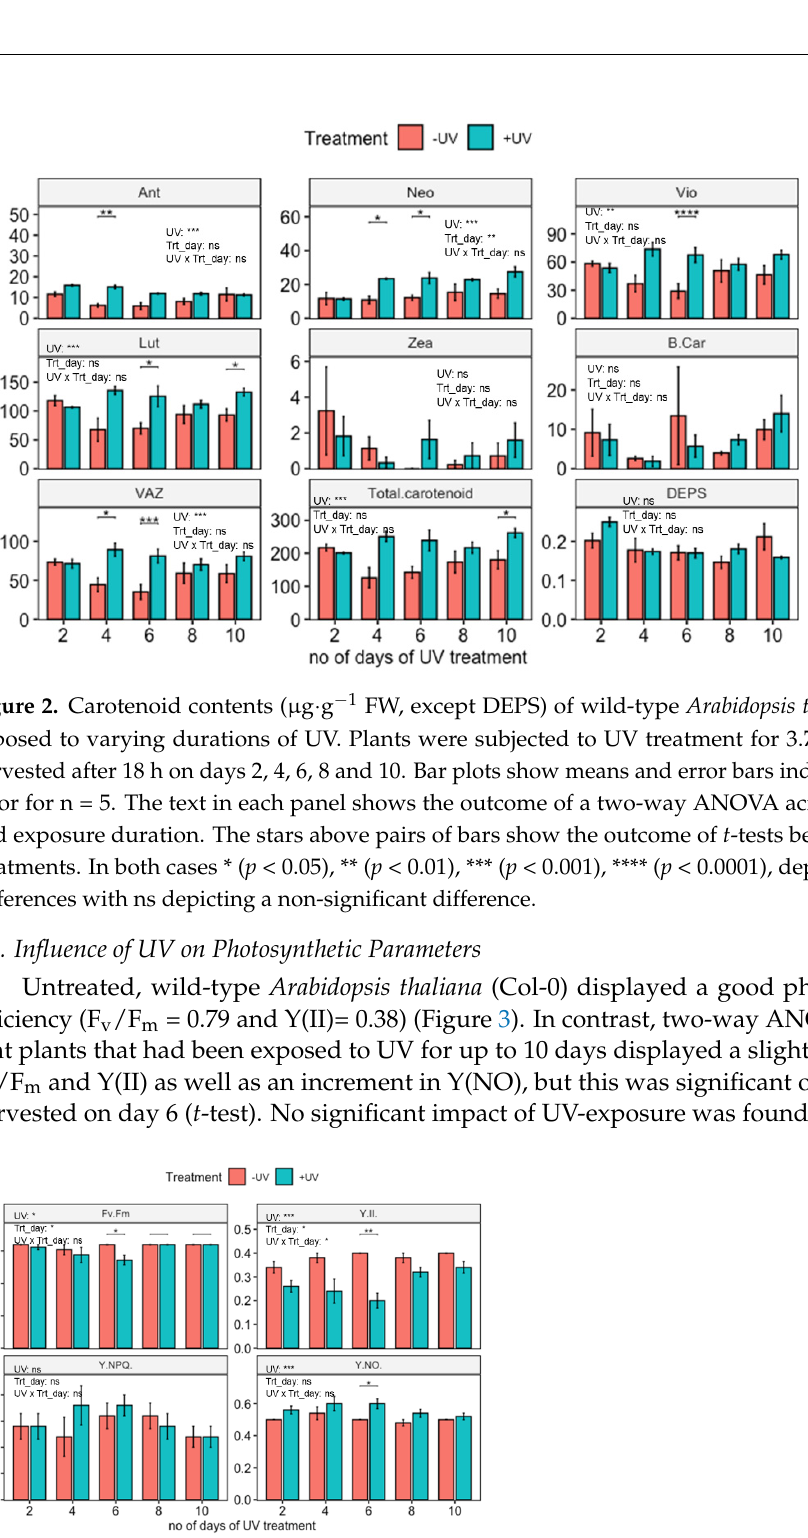
non-photochemical energy dissipation and Y(NPQ): the yield of the regulated non-photochemical energy dissipation. Bar plots show means and error bars for n = 5. The text in each panel shows the outcome of a two-way ANOVA across treatment and exposure duration. The stars above pairs of bars show the outcome of t -tests between the UV treatments. In both cases * ( p < 0.05), ** ( p < 0.01) and *** ( p < 0.001) depict significant differences with ns depicting a non-significant